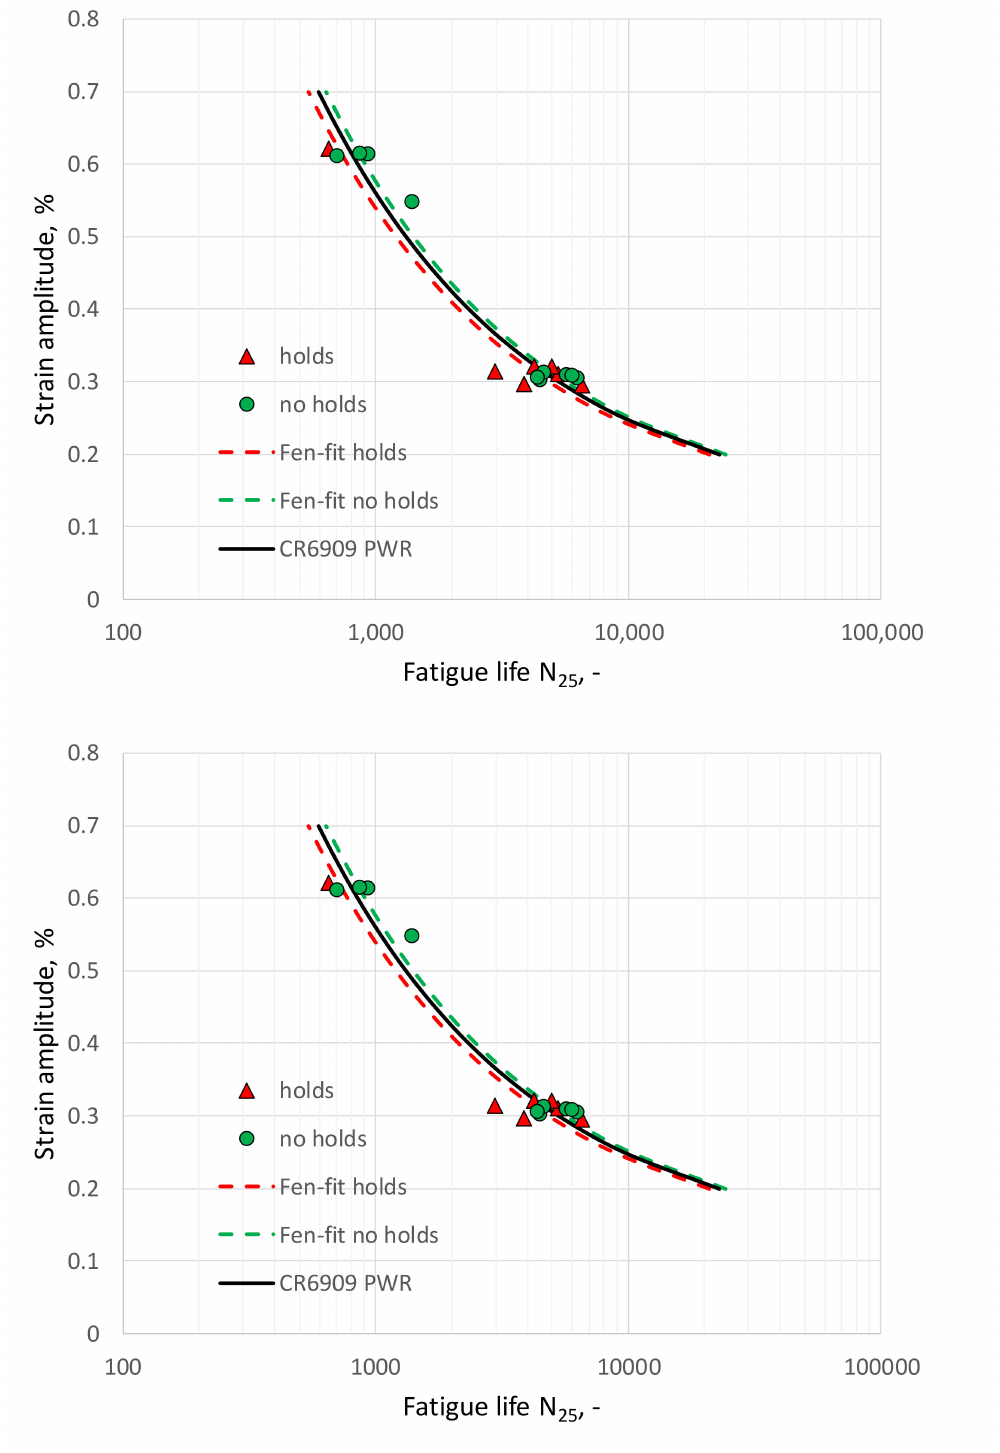
Figure 8. PWR fatigue life results (by holds) and NUREG / CR6909 mean PWR curve at 300 ◦ C (Fen =